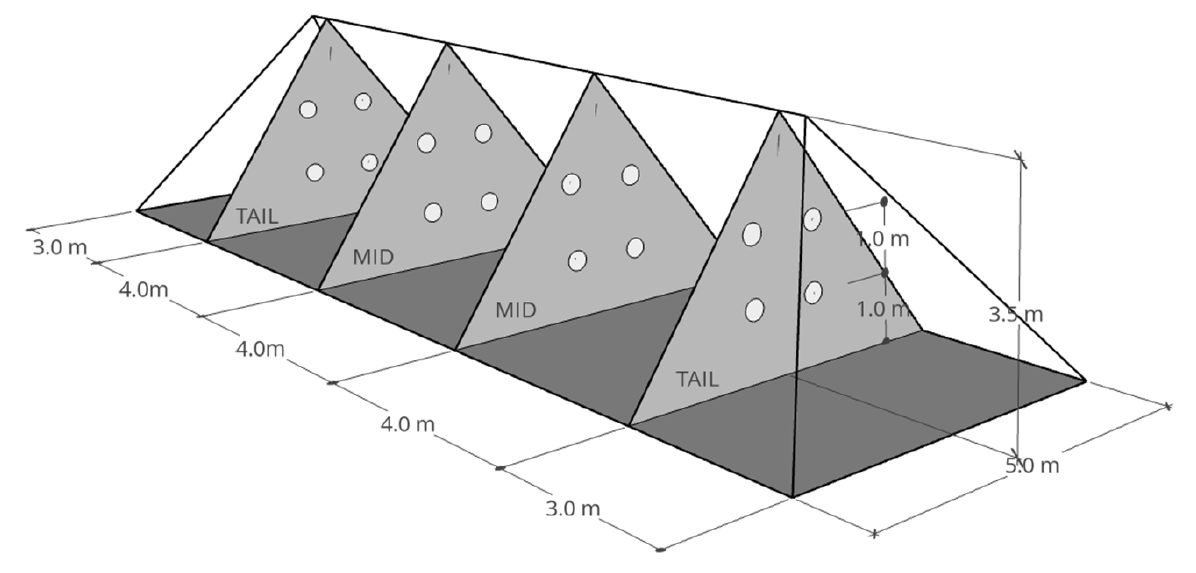
Figure 3. Approximate location of the balance bags (n = 16) in the mid and tail cross-sections of a pile at ca. 1 and 2 m elevations from the ground. Temperature sensors (thermocouples) were installed in the proximity of the balance bags. Table 1 lists the standards applied to analyze the initial and post-storing chip properties. The determination of DML was based on changes in mass and moisture content (MC, moisture mass fraction on wet basis, %) between the pile construction and the end of the experiment. Table 1. Standards applied to determine pre- and post-storing chip